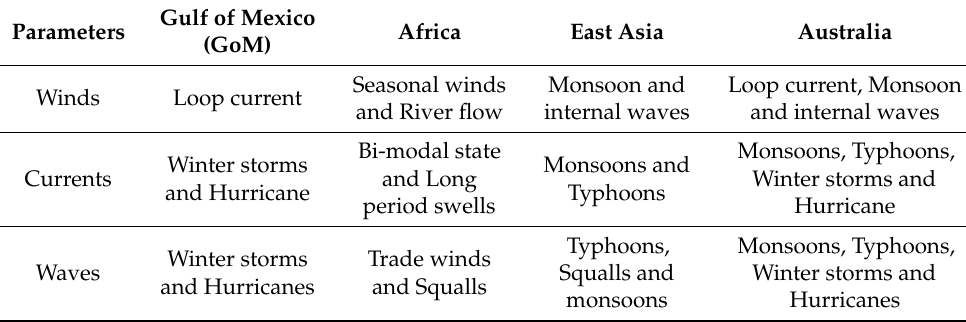
Table 2. Different environmental and ocean weather conditions globally. Parameters